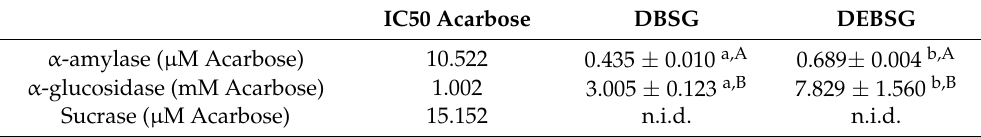
Table 8. Inhibition of digestive